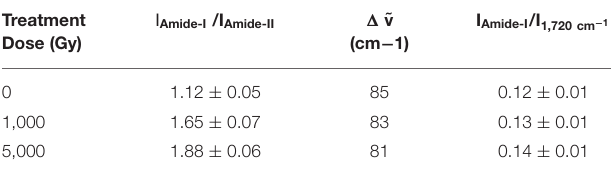
TABLE 2 | Intensity ratio of Amide-I and Amide-II bands (I Amide − I /I Amide − II ). Treatment Dose